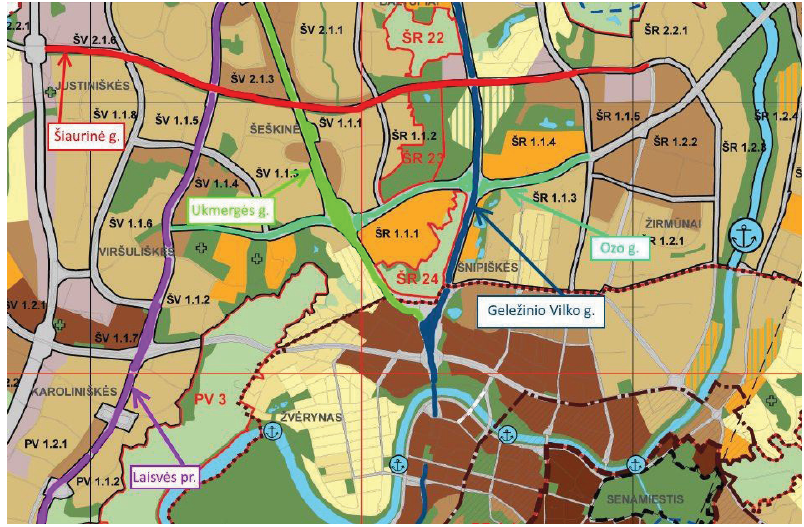
Figure 1. Siaurinė Street in